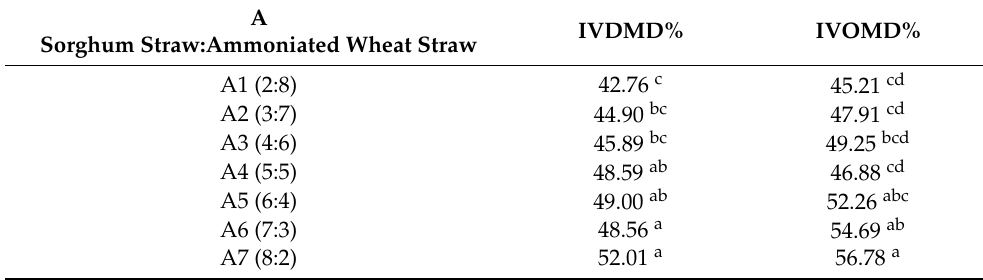
Table 5. In vitro degradability of dry matter and organic matter in 48 h of sorghum straw and ammoniated wheat straw with different